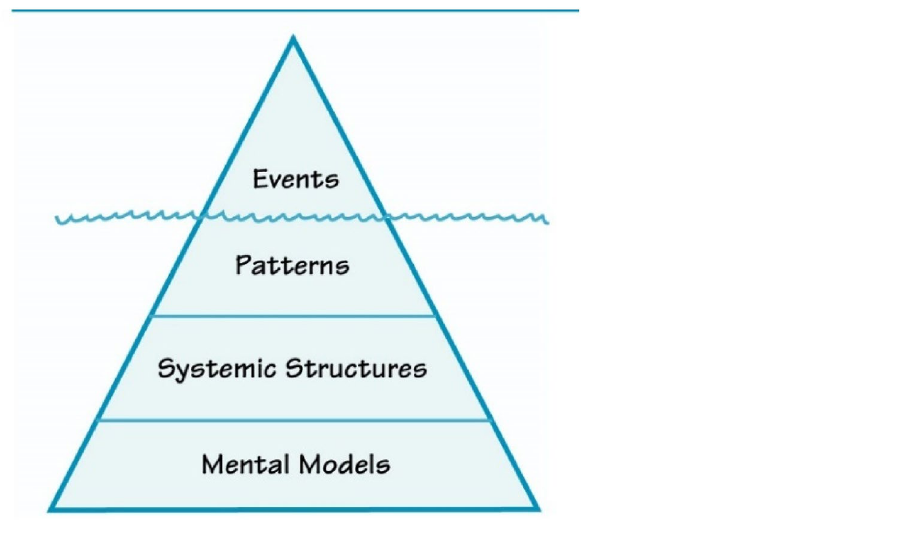
Figure 4. Four levels of system thinking 41